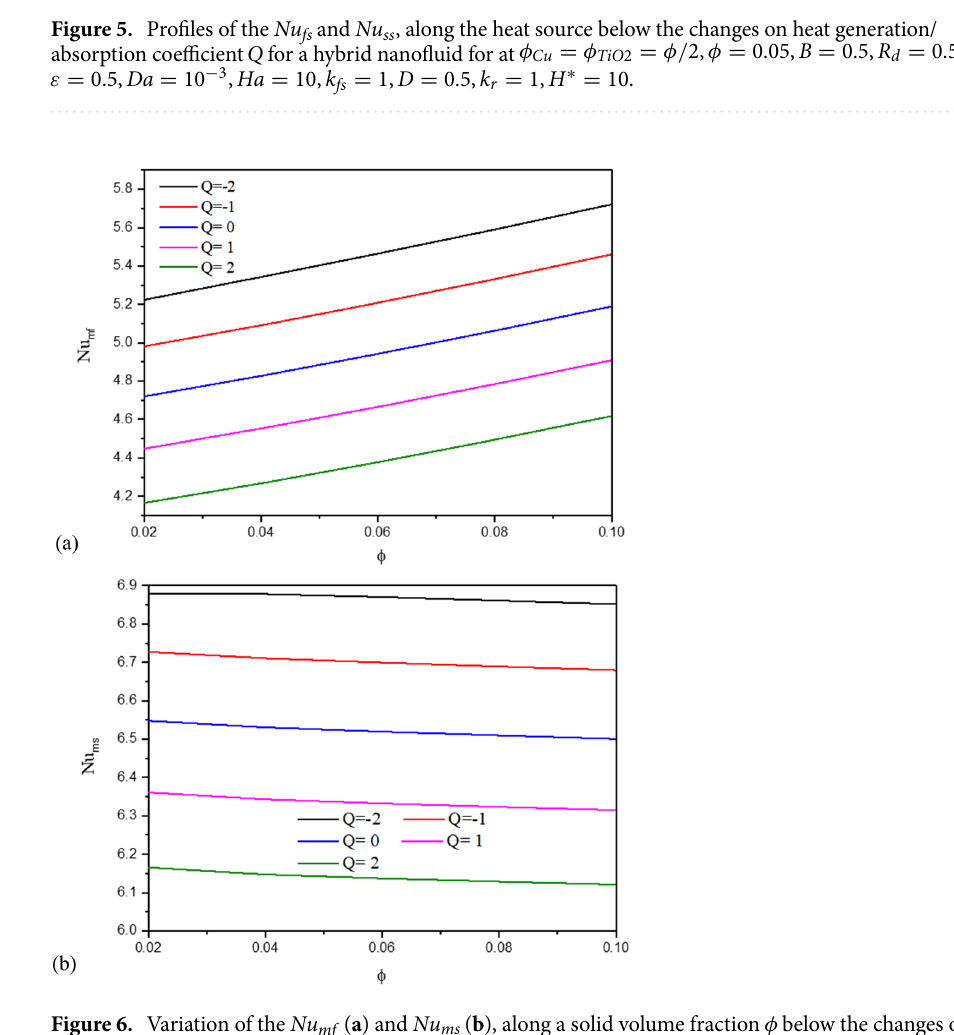
= φ = φ/ 2, B = 0.5, R = 0.5, TiO 2 d